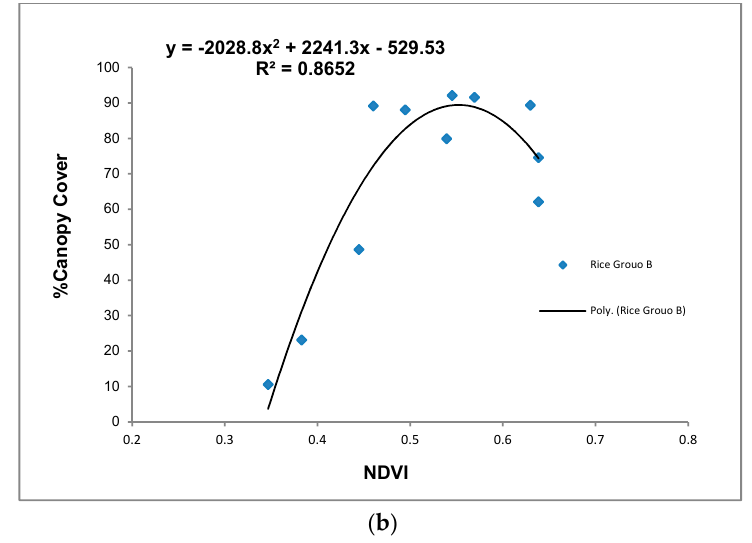
Figure 7. Relationship between NDVI and %CC for ( a ) Group A and ( b ) Group B.